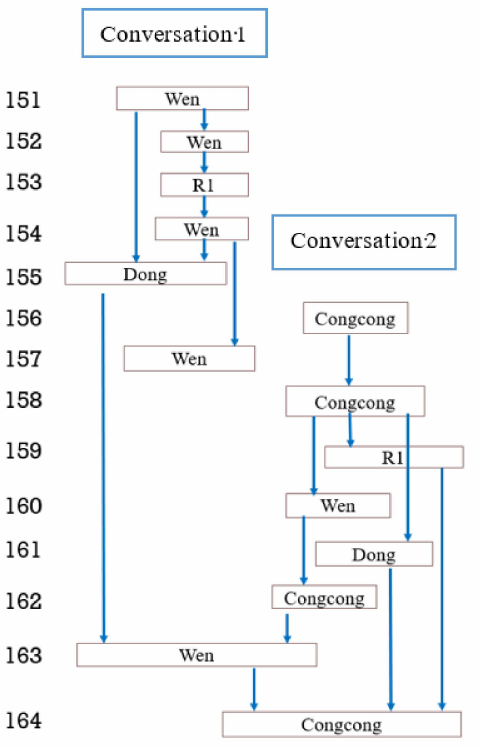
Figure 1. Intertwined conversation pattern as represented in Table